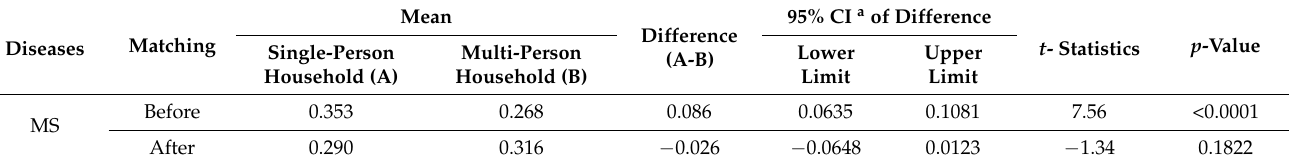
Table 5. Average treatment effect on the treatment of metabolic syndrome using